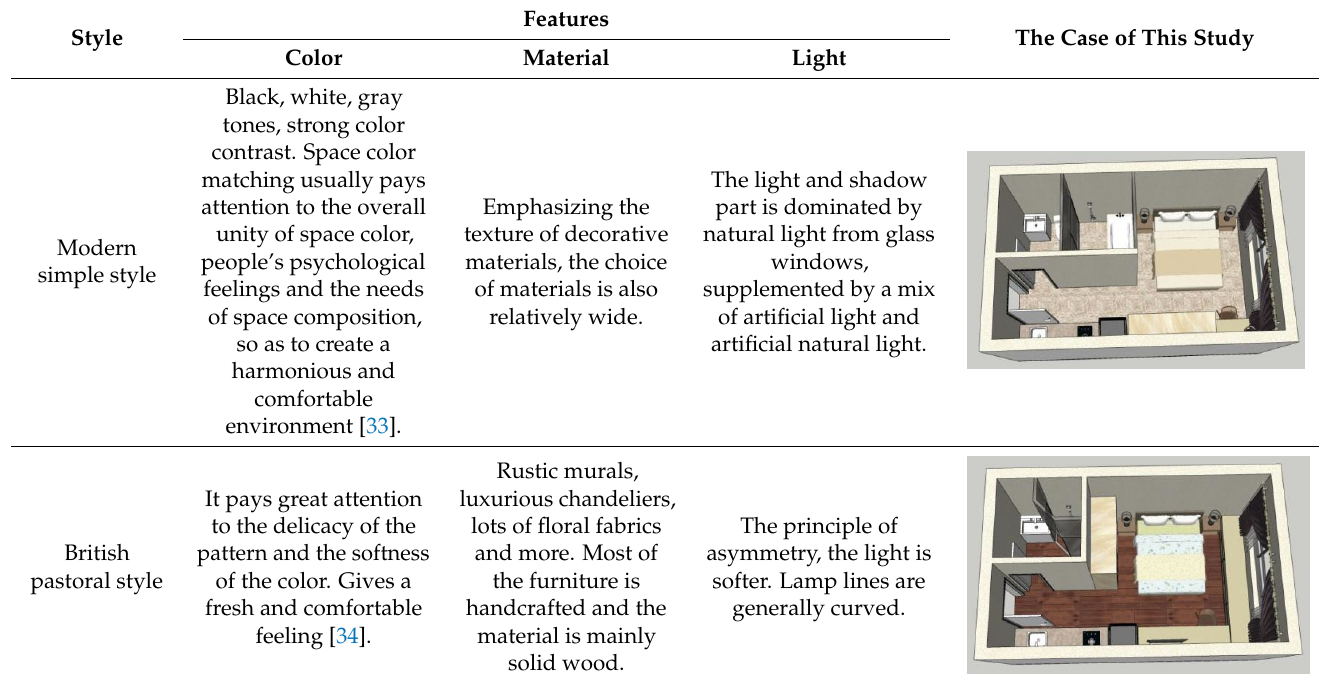
Table 2. Distinguish different hotel decoration styles .